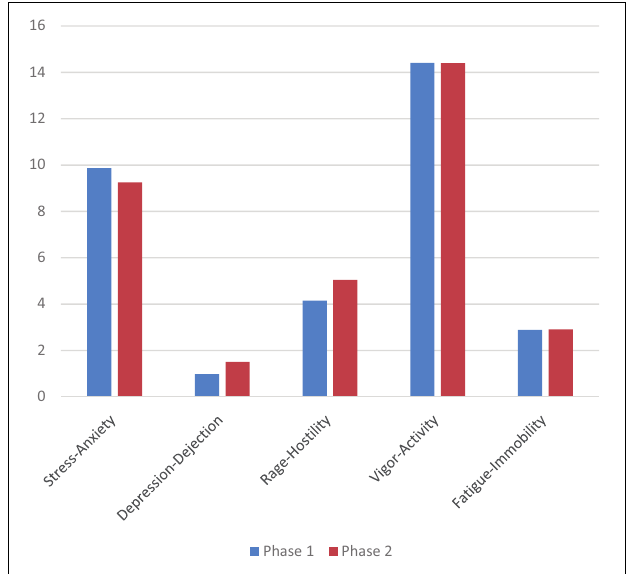
FIGURE 3 | Scores obtained on the POMS scales before the choreography, in phases 1 and 2 (2-month interval): stress-anxiety; depression-dejection; rage-hostility; vigor-activity; fatigue-immobility.